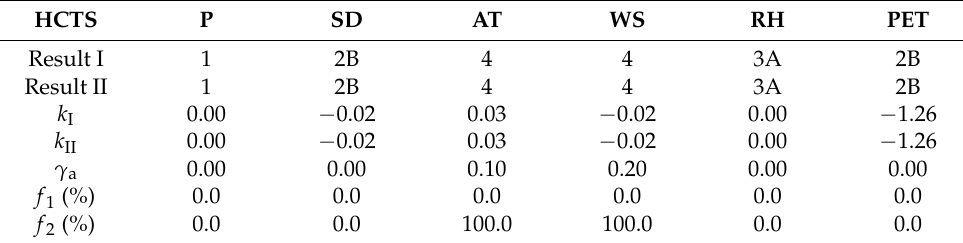
Table 6. Trend test results for the six HCTSs of the entire HRB at the 5% significance level. HCTS P SD AT